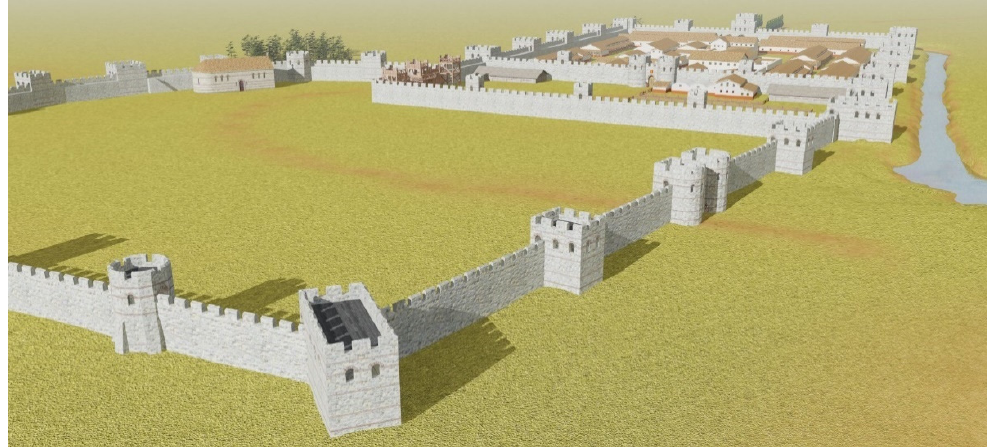
Figure 6. Reconstruction of the northern wall of area 3 (canabas) .